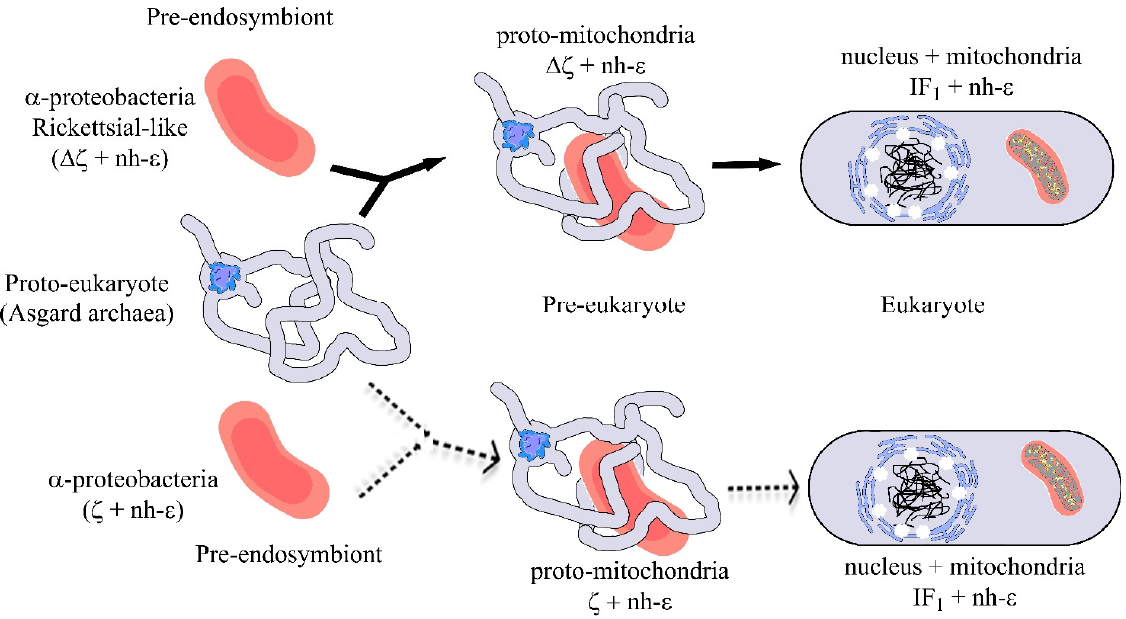
Figure 6. Simplified mitochondrial endosymbiotic events with an α -proteobacterial pre-endosymbiont having or lacking the ζ gene. The upper part (black arrows) shows the most likely mitochondrial endosymbiotic event, assuming that ζ is not a homolog of IF 1 , with a Rickett- sial-like pre-endosymbiont lacking the α PATPs ζ gene ( Δζ ), which evolves within a pre-eukaryote from being an intracellular parasite into a proto-mitochondria lacking ζ and already having a non-inhibitory ε subunit (nh- ε ) in its F-ATP synthase. This eventually transforms into mitochon- dria in an enucleated eukaryote. In this more likely scenario, ζ and IF 1 arose separately by conver- gent evolution. In mitochondria, IF 1 evolved not only to preferably inhibit the F 1 F O -ATPase activity, but also to stabilize the mitochondrial F-ATP synthase dimers, and further oligomers that give its shape to the cristae of the mitochondrial inner membrane (see yellow spots of F-ATP synthases in the curved portions of cristae and Figure 7). The lower part (dashed light arrows) shows a less likely alternative scenario where ζ is the predecessor of IF 1 and where an α -proteobacterial